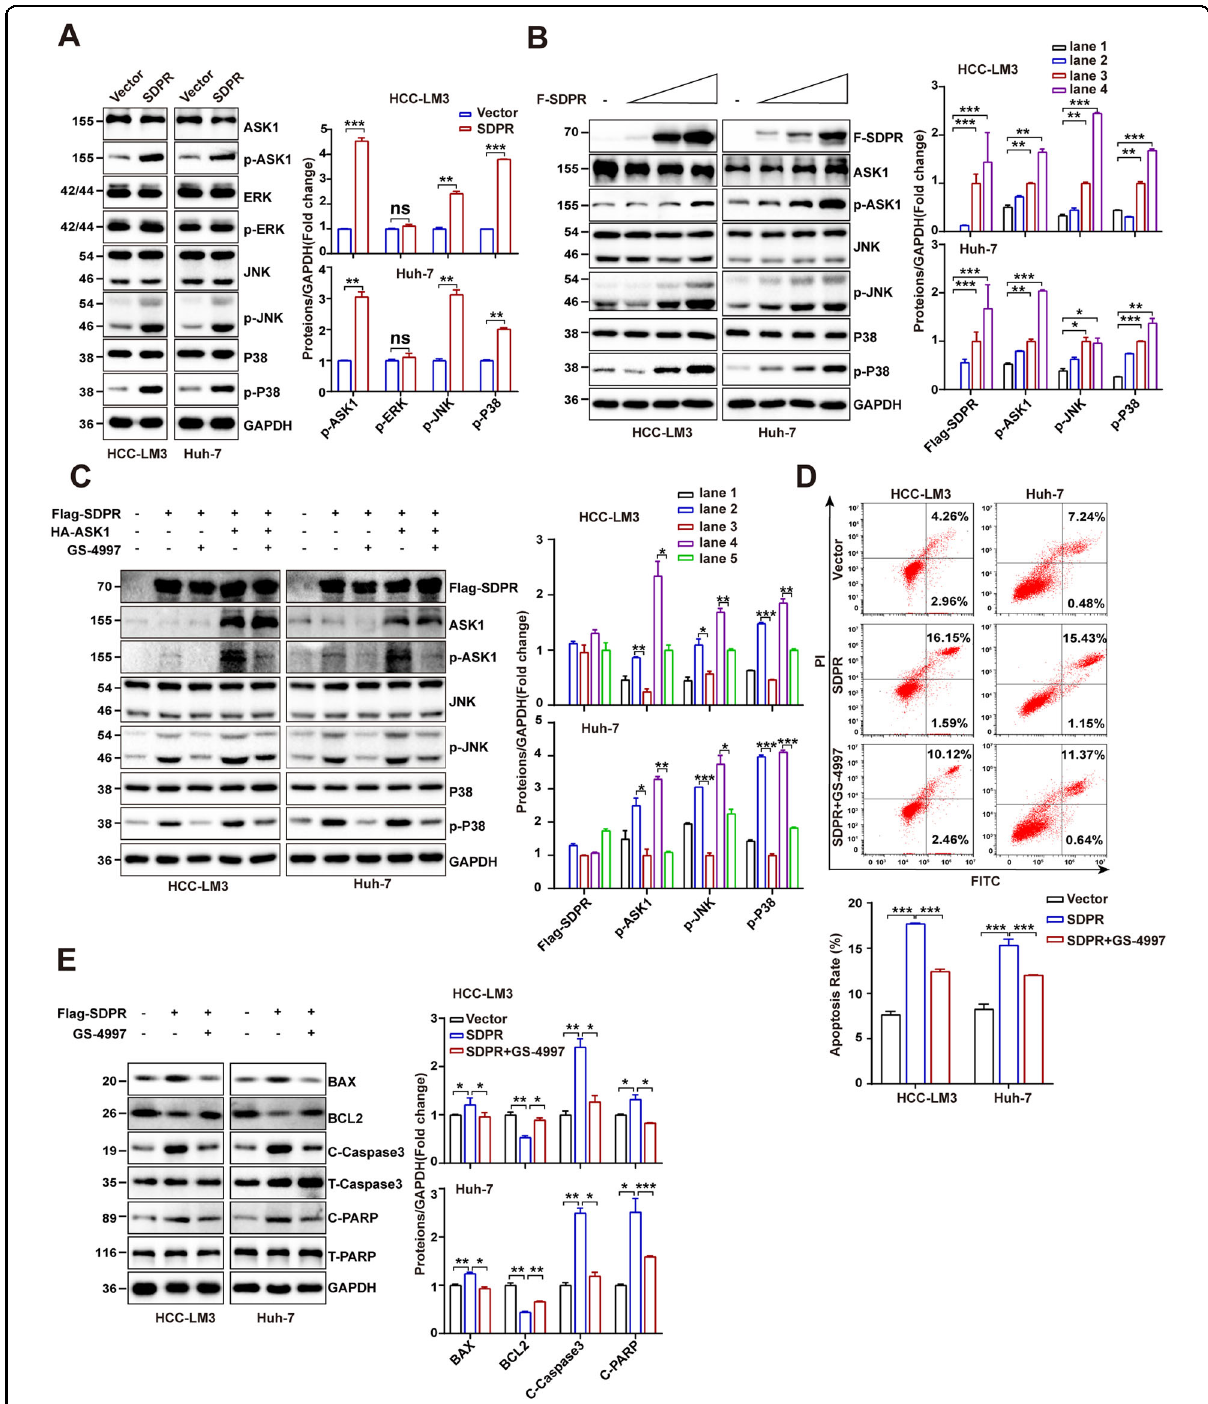
Fig. 6 SDPR promoted the apoptosis of HCC cells via ASK1-JNK/p38 MAPKs signal pathways. A The levels of ASK1-MAPKs pathways key proteins, phosphorylated and total ASK1, ERK1/2, JNK1/2, and p38 in vector and SDPR overexpressing HCCLM3 and Huh-7 cells. B The effect of SDPR gradient transfection in HCCLM3 and Huh-7 cells on proteins level of phosphorylation and total ASK1, JNK1/2, and P38. C The Western blot evaluation of protein expression of phosphorylated and total ASK1, JNK1/2, and p38 in SDPR and ASK1 cotransfected treatment of Huh-7 and HCCLM3 cells with ASK1 inhibitor GS-4997. D FACS analysis showed GS-4997 inhibited ASK1-induced HCC apoptosis. E The levels of apoptotic related proteins changes after treated with GS-4997 in HCCLM3 and Huh-7 cells. * p < 0.05; *** p < 0.01; *** p <